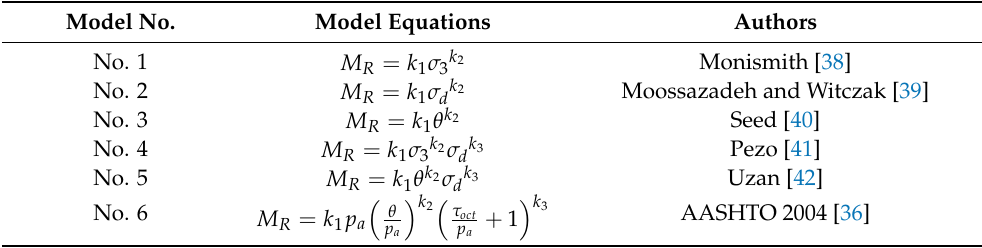
Table 6. Representative prediction models of the resilient modulus surveyed from the existing literature.